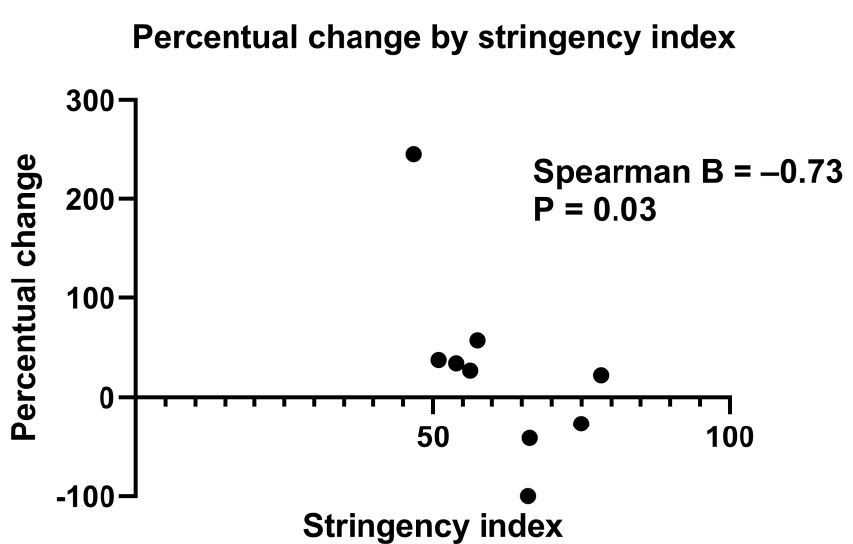
Figure 4. Scatter plot showing the percentage change of mean IBA patients born per month (from pre-lockdown to lockdown period) for every stringency index of the participating centres. n = 9, Hannover and Padova were excluded (three centres from United Kingdom were merged into one). Spearman’s correlation coefficient = − 0.73, p =